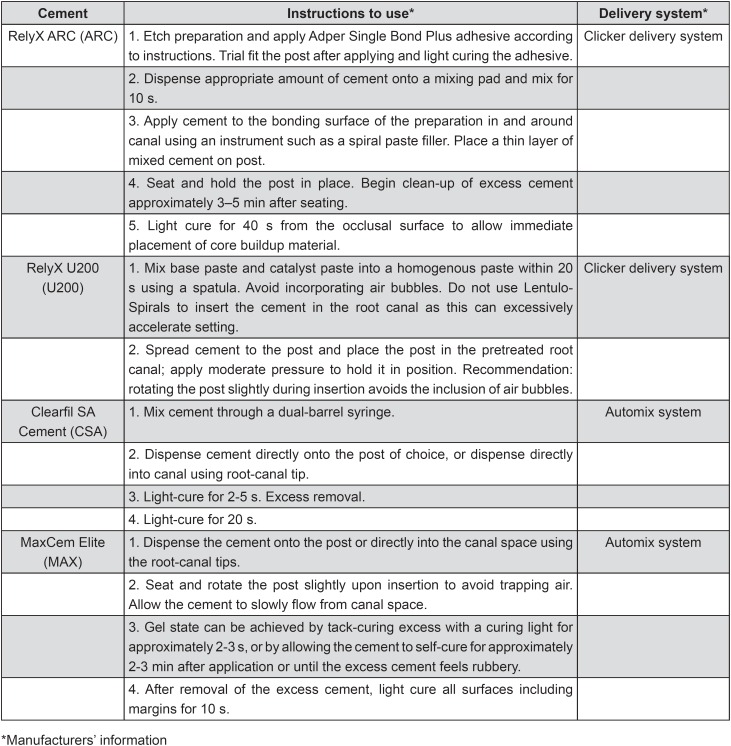
Application modes of the cements investigated